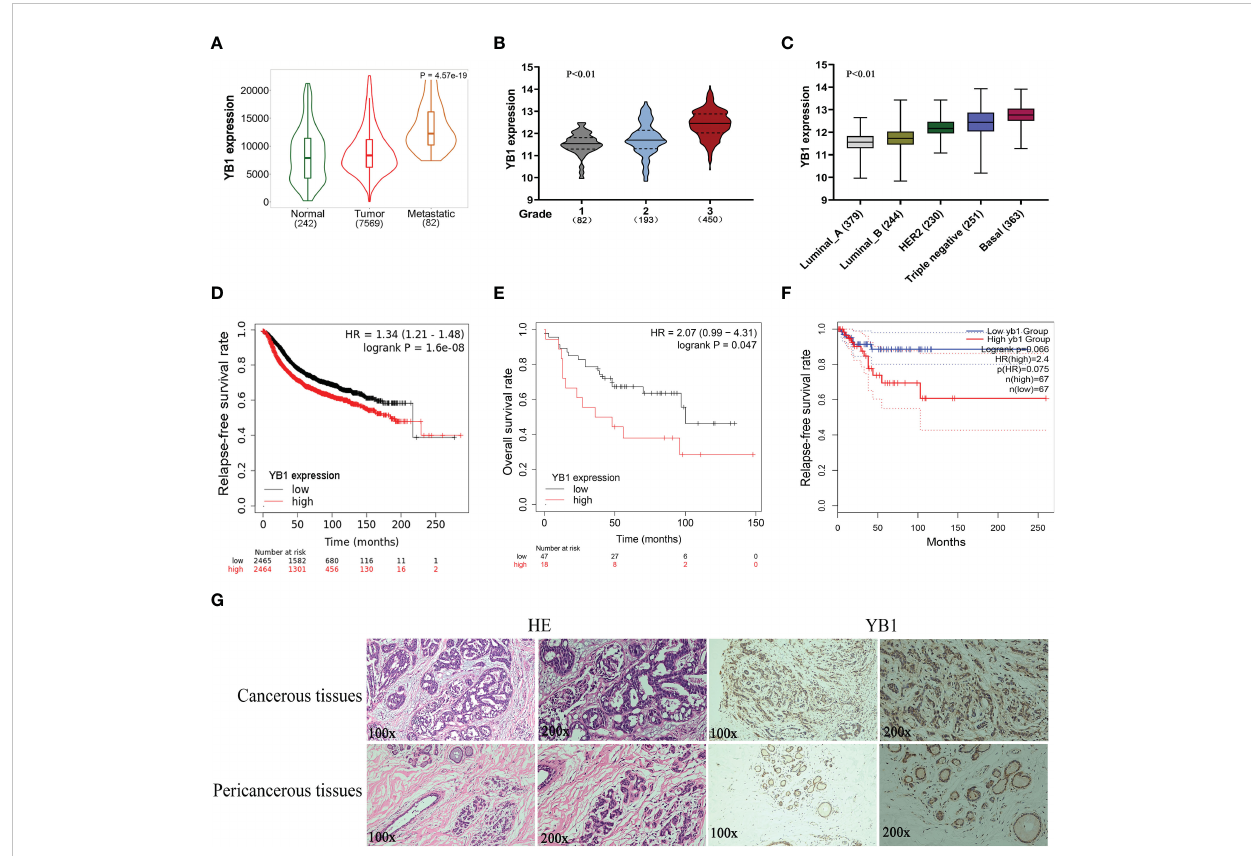
FIGURE 1 The upregulation of YB1 in breast cancerous tissues was associated with poor clinical outcomes. (A) Relative expression of YB1 in normal or cancerous tissues of patients with breast cancer. The expression level of YB1 in metastatic cancerous tissues was speci fi cally elevated compared with normal or non-metastatic tissues (https://tnmplot.com). (B) Expression level of YB1 in breast cancer patients under different clinical stages (http://gent2.appex.kr/gent2/). (C) The relationship between YB1 expression and breast cancer types (http://gent2.appex.kr/gent2/). (D-F) Kaplan – Meier survival rates for patients with breast cancer strati fi ed by YB1 expression. The survival rates for patients were plotted separately according to YB1 expression at the mRNA (D) or protein level (E) (http://kmplot.com/analysis/). The most remarkable difference emerged in patients with basal- like/triple-negative breast cancer (F) . (G) Immunohistochemical analysis of YB1 in solid tumors. Paired paracarcinoma and carcinoma tissues were excised from the same patient with breast